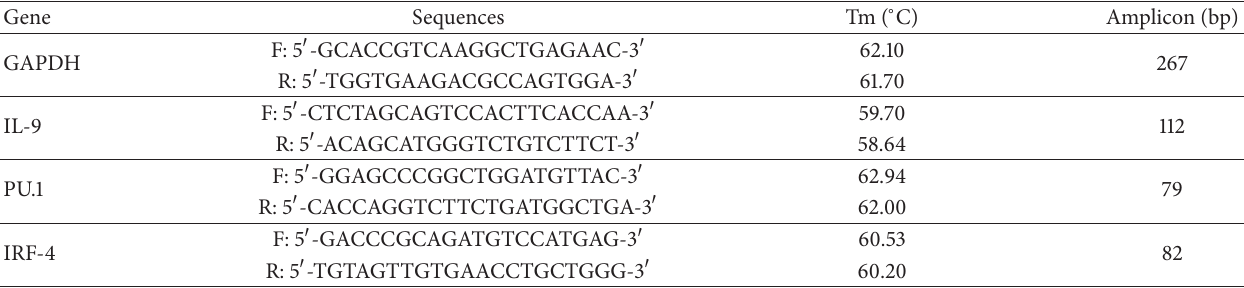
Table 1: Primer sequence and amplicon of GAPDH, IL-9, PU.1, and IRF-4.